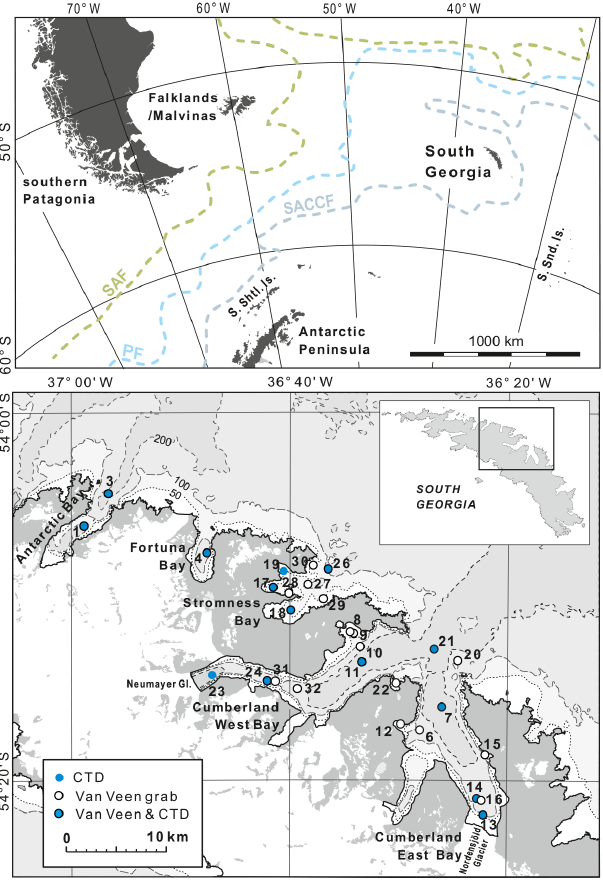
Figure 1. Study area. The upper map (after https://freevectormaps. com, last access: 8 October 2021) shows the position of South Geor- gia in the southwestern Atlantic and the southern Antarctic Cir- cumpolar Current front (SACCF), the polar front (PF), and the sub- antarctic front (SAF), after Orsi et al. (1995). The lower map (after the “South Georgia and The Shackleton Crossing” map 1:200000, published by the British Antarctic Survey in 2017, and “Admi- ralty Chart 3588: Approaches to Stromness and Cumberland Bays”, 1:50000, second edition, 23 January 2003) shows locations of sam- pling stations and those conductivity, temperature, and depth (CTD) stations, for which the data profiles are shown in Fig.